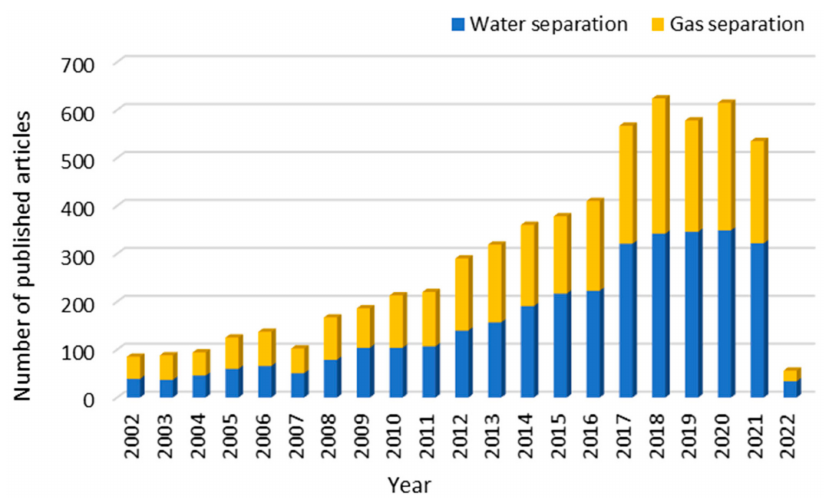
Figure 1. Milestone of hollow fiber membranes development.